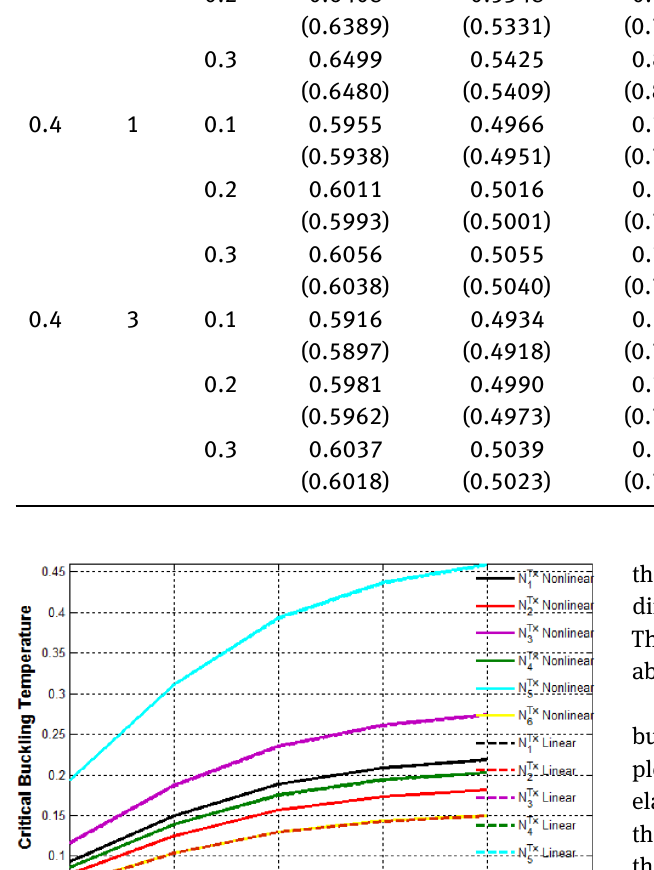
puter program is generated so as solve numerous prob- lems. Unless stated the individual ply thickness of lam- inated composite maintained equal. To check the exact- ness of the MATLAB code, the results of the critical buck- ling temperature under different boundary condition, for different elasticity ratio with variation in ratio of coeffi- cient of thermal expansion (CTE) and aspect ratio of 10 are get validated with Ref. [53] as shown in Table 8.